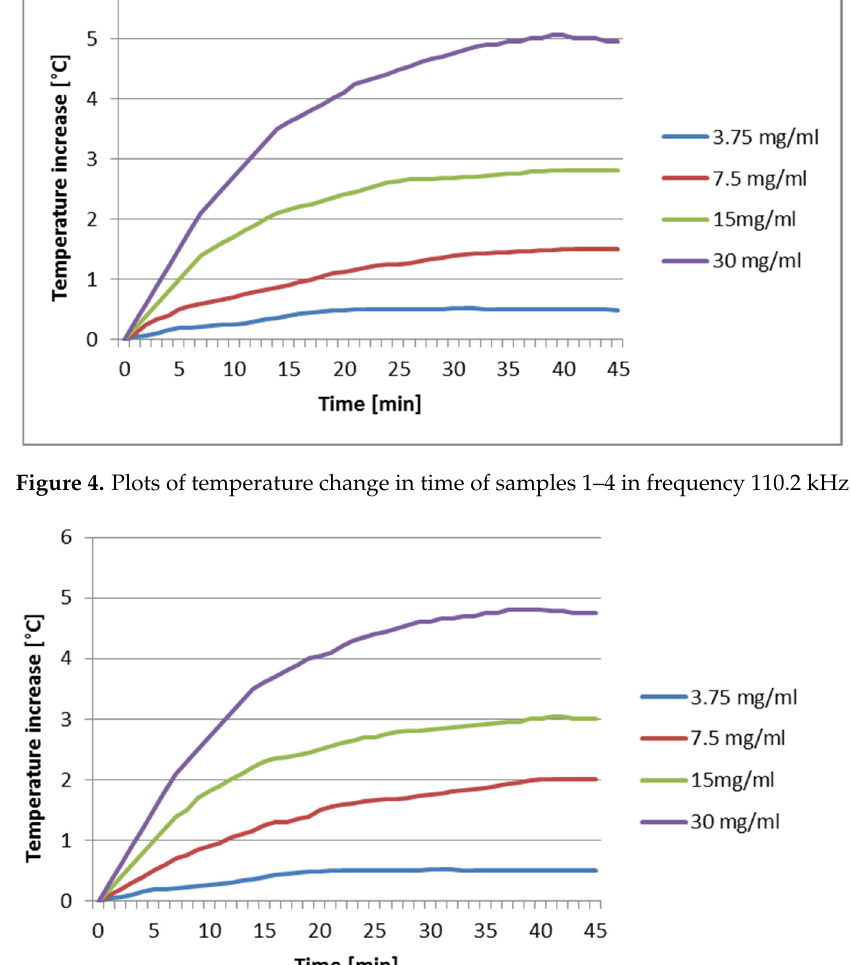
Figure 4. Plots of temperature change in time of samples 1–4 in frequency 110.2 kHz.